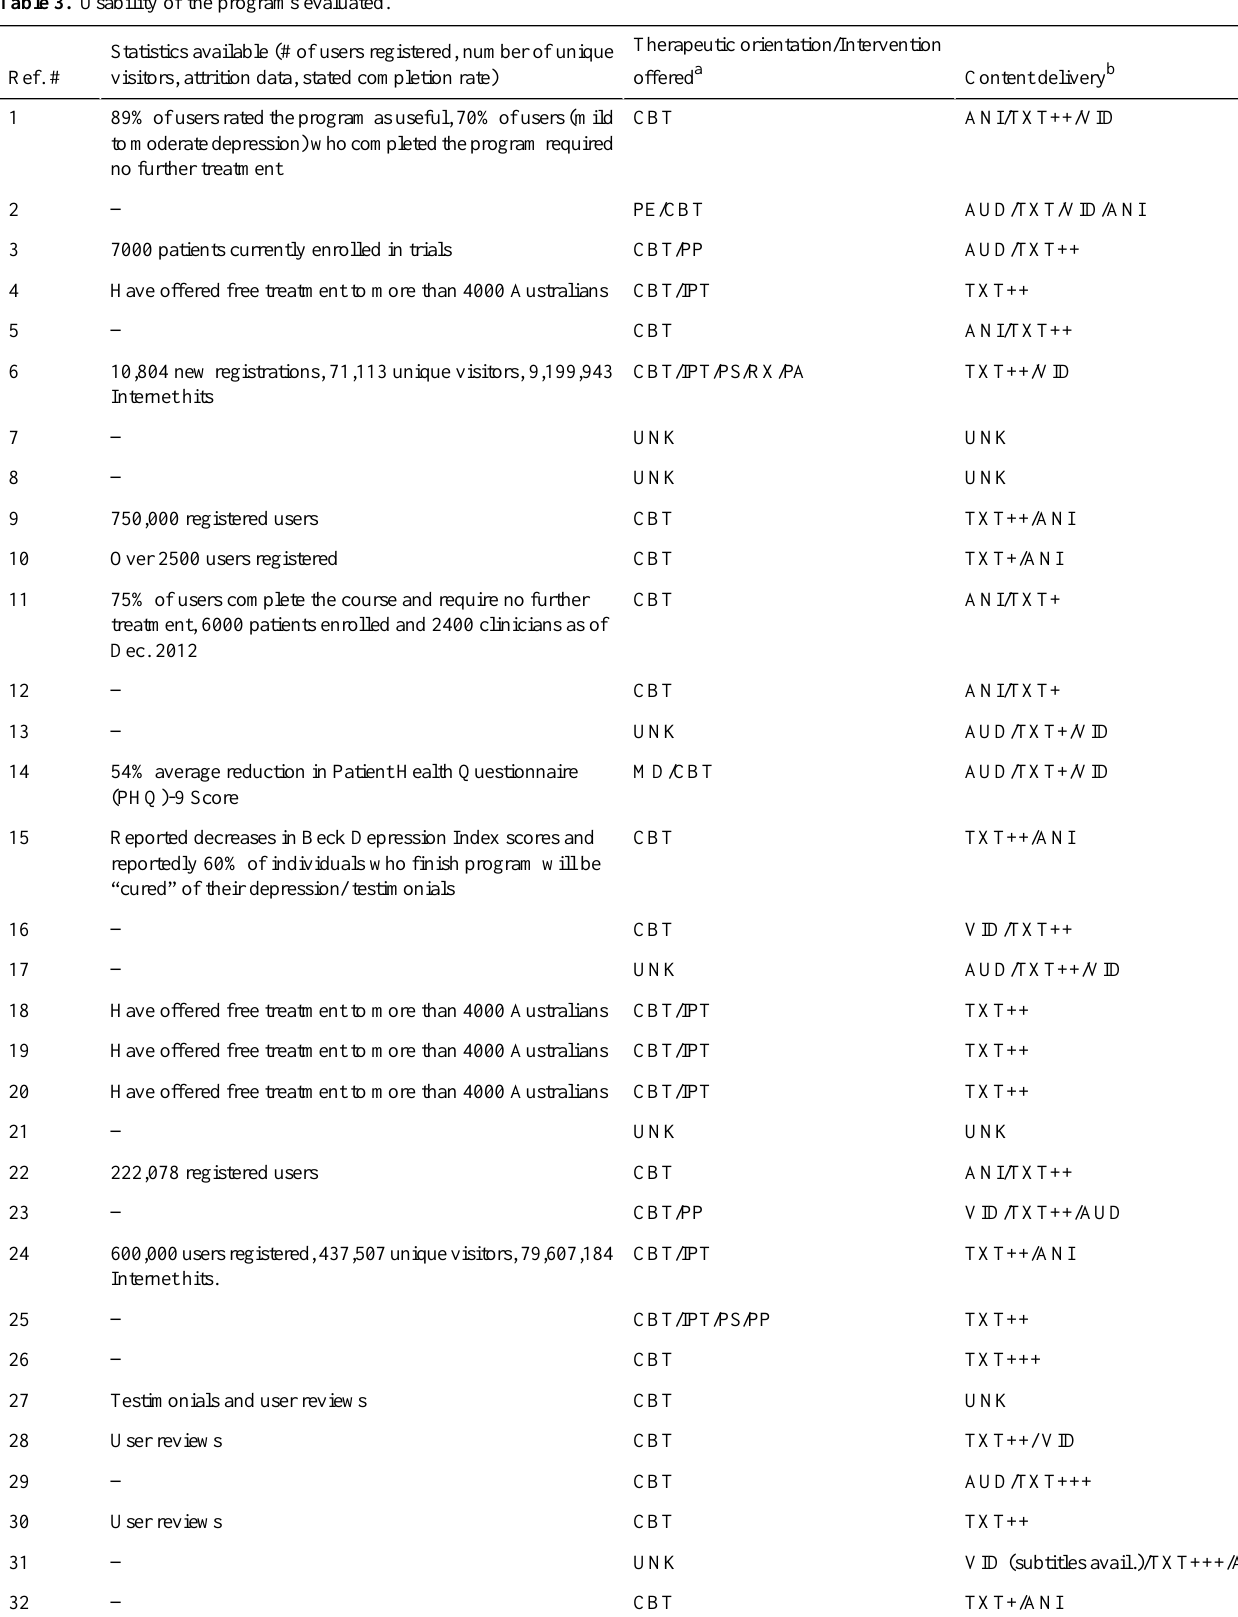
Table 3. Usability of the programs